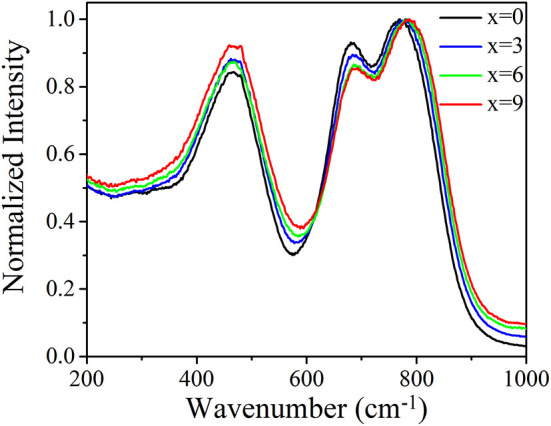
Normalized Raman spectra of TGB glasses with different BaF2 amounts.